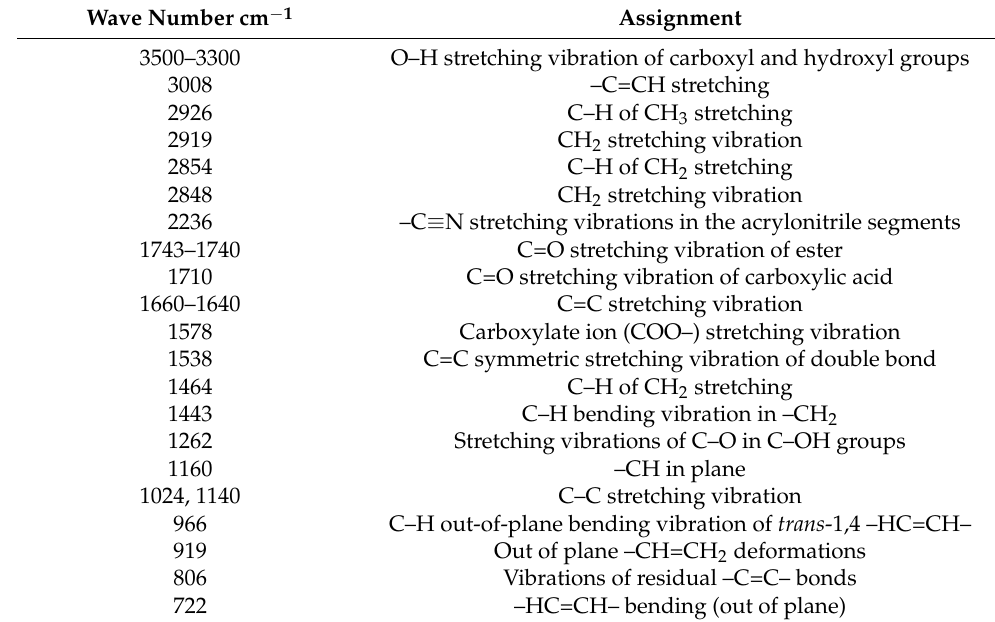
Figure 1. Representative ATR-FTIR spectra of the ( a ) SBO and ( b ) SBOFA.